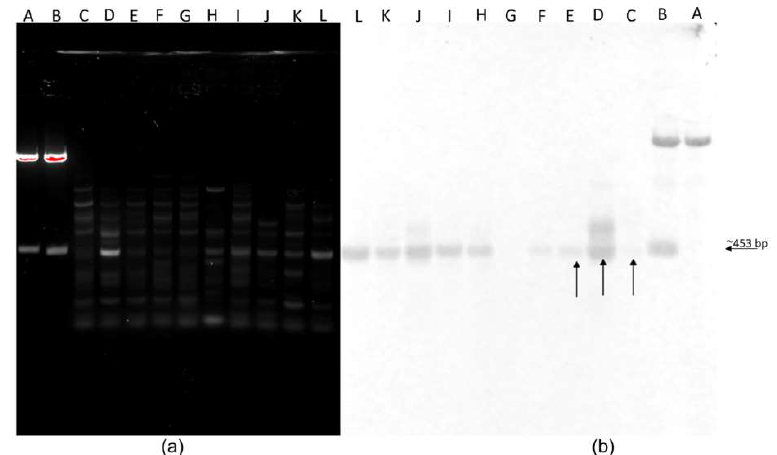
Figure 3. SCAR-2 primer products detection using gel electrophoresis and Southern blot. ( a ) SCAR-2 primer amplification products resolved on 1.5% agarose gel and ( b ) Southern blot results using DIG-labelled ACM941 specific SCAR probe. Lane descriptions: A —plasmid-24 RE (negative control); B —plasmid-20 RE (positive control); C — C. rosea strain 88-710; D — C. rosea strain ACM941; E — C. rosea